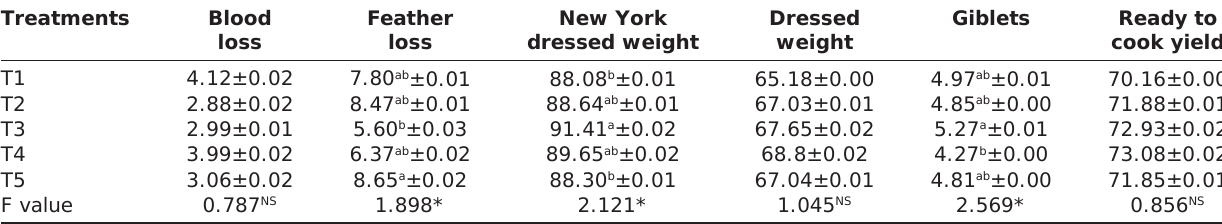
Table-2: Effect of phytobiotics-containing herbal seeds as feed supplements on carcass traits (%) at 8 th week of age in turkey poults (n=6).